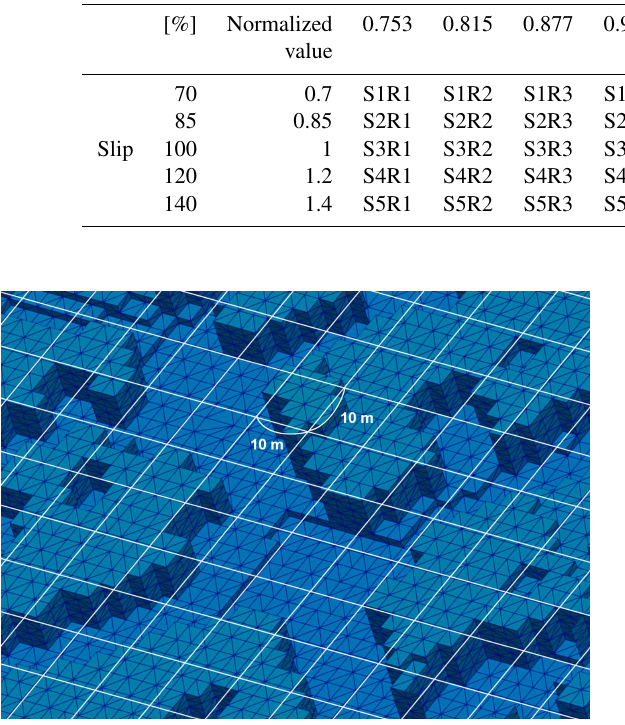
Figure 10. An image of mesh for evaluating tsunami